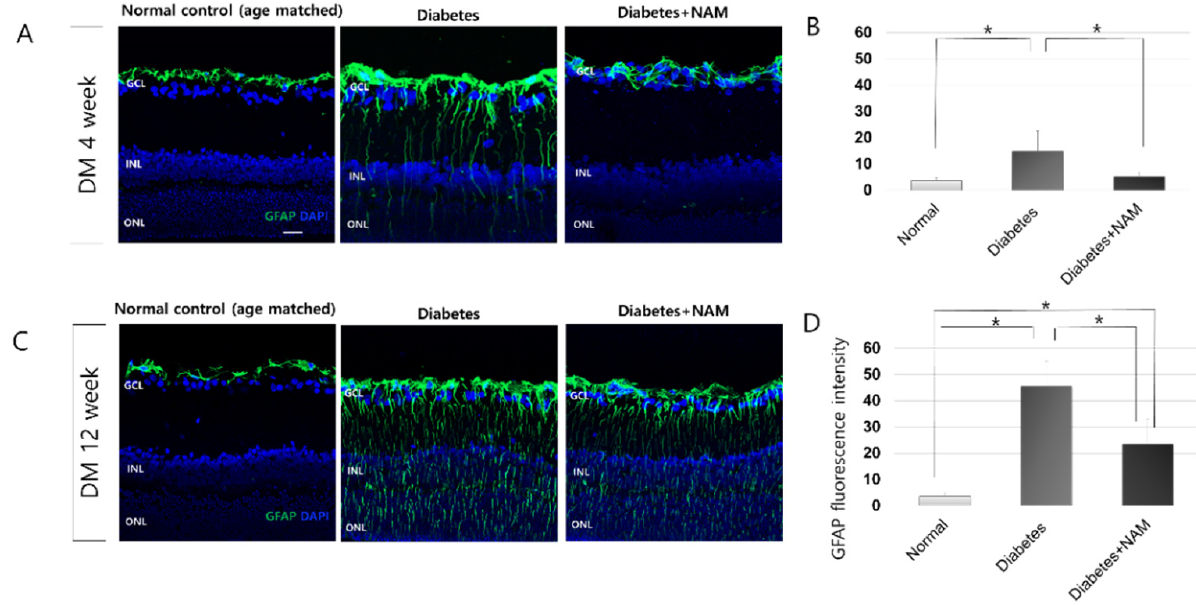
Figure 6. Glial activation. Glial fibrillary acidic protein (GFAP) immunofluorescence staining was increased, extending to the outer nuclear layer compared to the normal control group at 4 and 12 weeks after onset of diabetes ( A , C ). Nicotinamide treatment significantly attenuated GFAP expres- sion at 4 and 12 weeks after induction of diabetes (Both p < 0.001; ( B , D )). Scale bar = 20 µm . DM, diabetes mellitus; NAM, nicotinamide . GCL, ganglion cell layer. INL, inner nuclear layer. ONL, outer nuclear layer. *, significantly different as indicated ( p < 0.05).